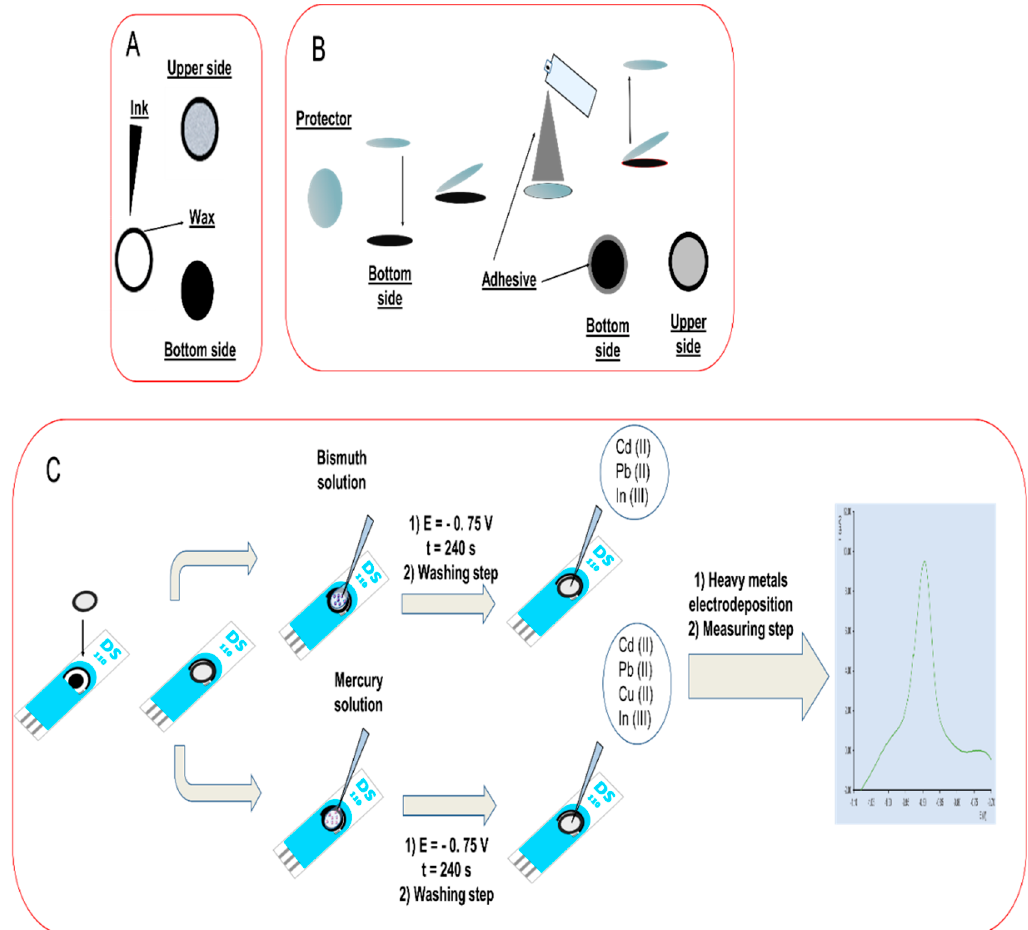
Figure 1. Schematic diagram showing the preparation of the paper-based electrodes. ( A ) Modification of cellulose substrate by addition of carbon ink on one side, having the platform with two visually different sides. Solution was added with a micropipette through the upper side. ( B ) Adhesive spraying on the protected working electrode. ( C ) Overlapping process of the bottom side of the paper electrode (the one with the ink) on the screen-printed card and modification with mercury (II) acetate or bismuth (III) standard solutions.